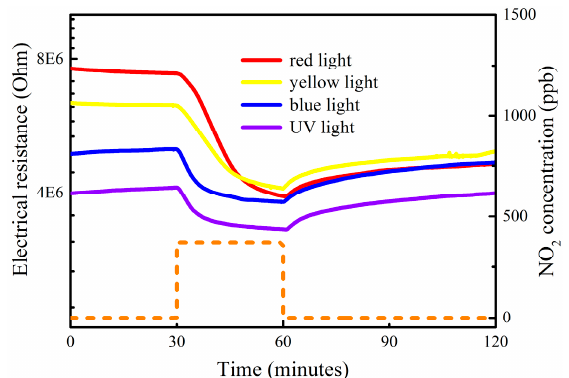
Figure 6. The electrical resistance of Sample 1 versus 372 ppb NO 2 gas illuminated by different light at room temperature.